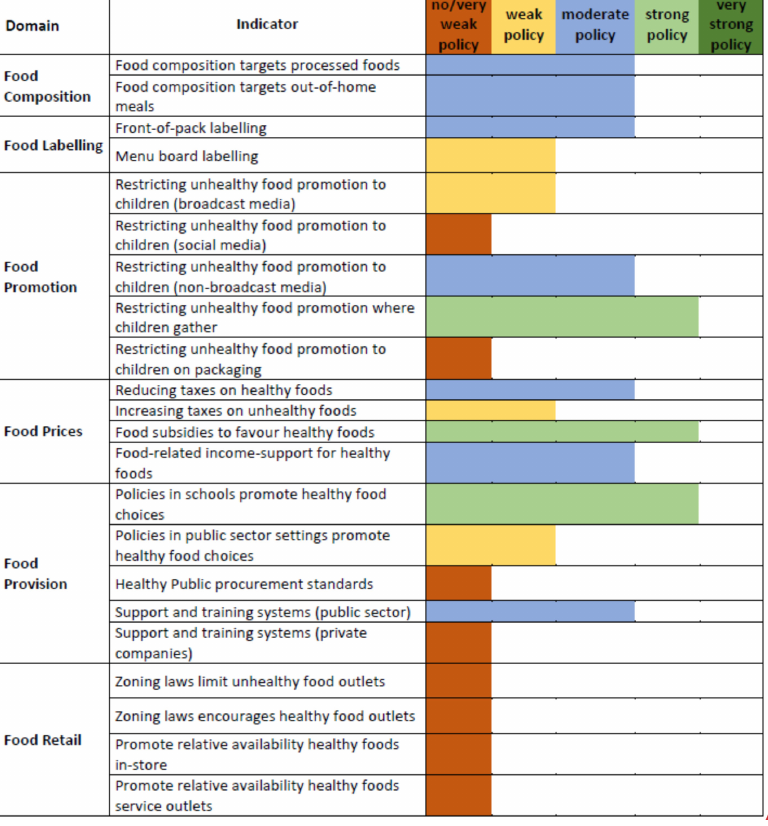
Figure 3. Results of the implementation of food-related policies in Poland across the Food-EPI domains and